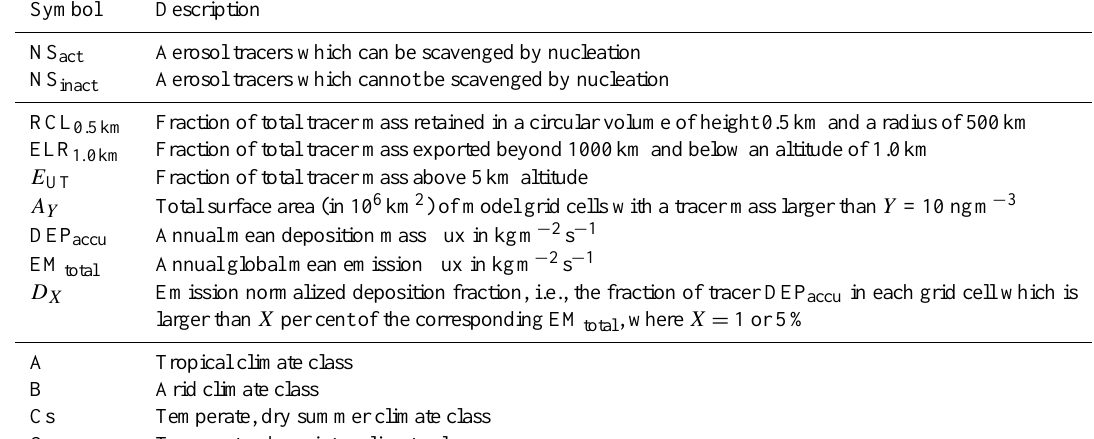
Table 2. Brief description of symbols used in this study.